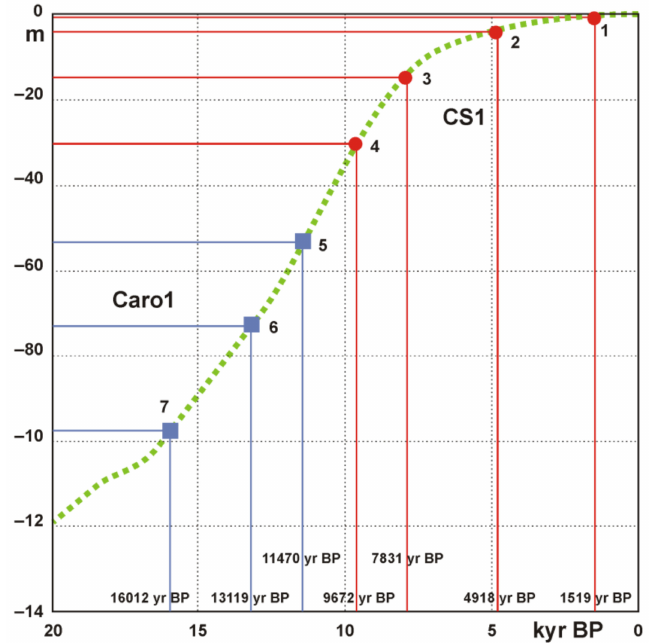
Figure 9. Eustatic and glacio-hydro-isostatic predictions for Italian sites for the past 20,000 years (redrawn and simplified from [66]). Samples of the cores CS1 (red dots) and Caro1 (blue squares) are plotted on the curve (1: CS1_38 cm; 2: CS1_108 cm; 3: CS1_148 cm; 4: CS1_bottom; 5: Caro1_20 cm; 6: Caro1_50 cm; 7: